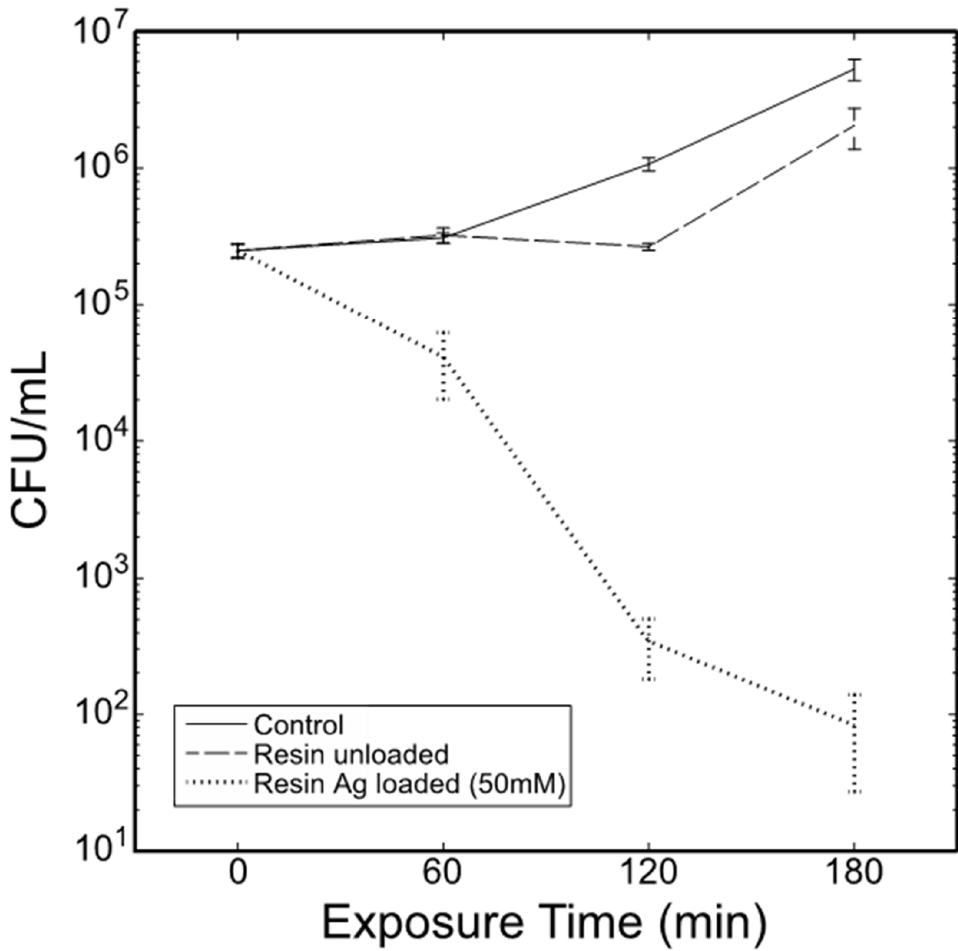
Figure 7. Comparative in vitro antibacterial activity of a single unloaded resin bead and a single resin bead loaded with 22.7 wt% Ag nanoparticles (made with 50 mM AgNO 3 ) against Escherichia coli .